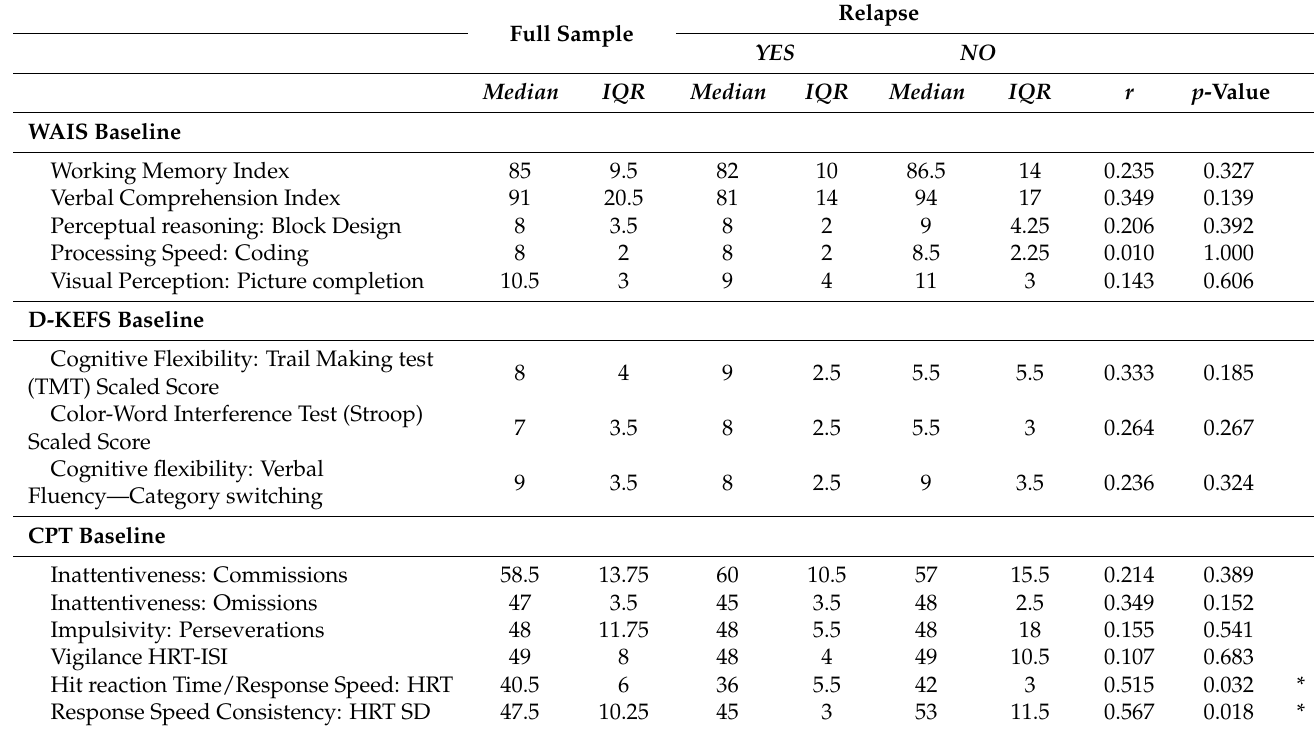
Table 1. The group level descriptive statistics of the baseline and repeated measures for the full sample and between group comparisons for the relapsed and non-relapsed participants. WAIS: Wechsler Adult Intelligence scale 4th ed., D-KEFS: Delis-Kaplan Executive Function System, CPT: Conners Continuous Performance test, 3rd ed. Wilcoxon–Mann–Whitney test for between